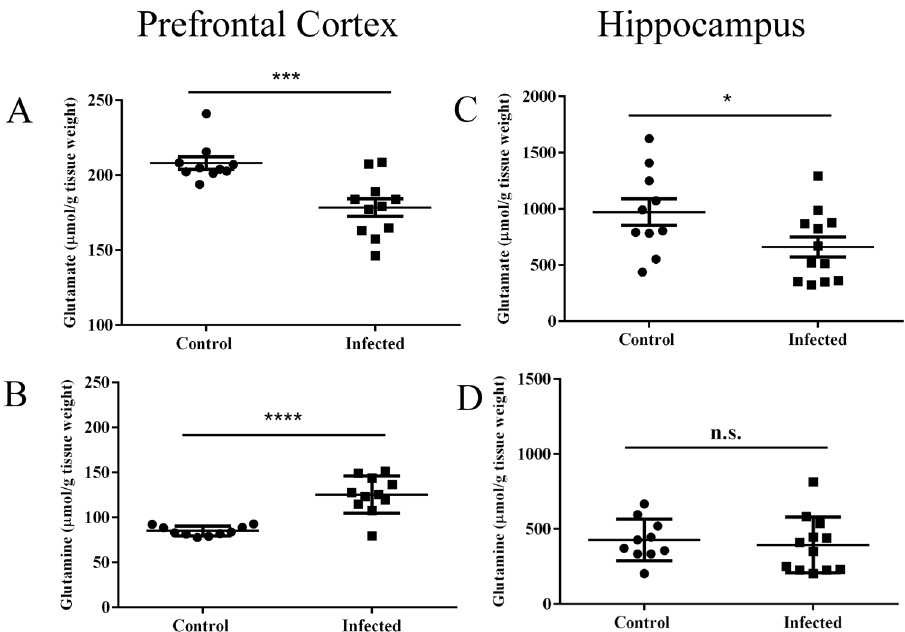
Figure 4. Reduction of glutamate in prefrontal cortex and hippocampus in T. gondii chronic infection. Glutamate was reduced in the prefrontal cortex ( A ) and hippocampus ( C ), while glutamine was increased in the prefrontal cortex ( B ) and unchanged in the hippocampus ( D ). Asterisks indicate statistically significant differences and N.S. not significance. * p < 0.05; *** p < 0.001 and **** p < 0.0001. Symbols correspond to individual subjects. Horizontal lines represent mean values for each group. Prefrontal cortex: control (n = 10), infected (n = 11). Hippocampus: control (n = 7), infected (n =